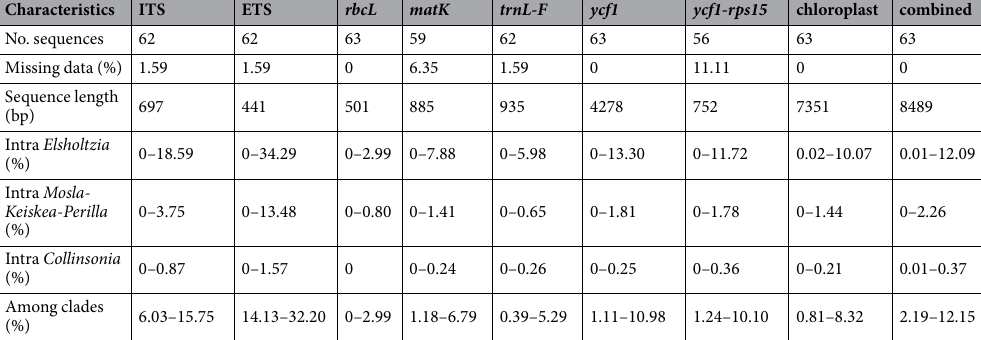
Table 1. Sequence characteristics of Elsholtzia , Mosla - Keiskea - Perilla , Collinsonia , and sequence divergence values, which were estimated with pairwise distance (p-distance, pairwise